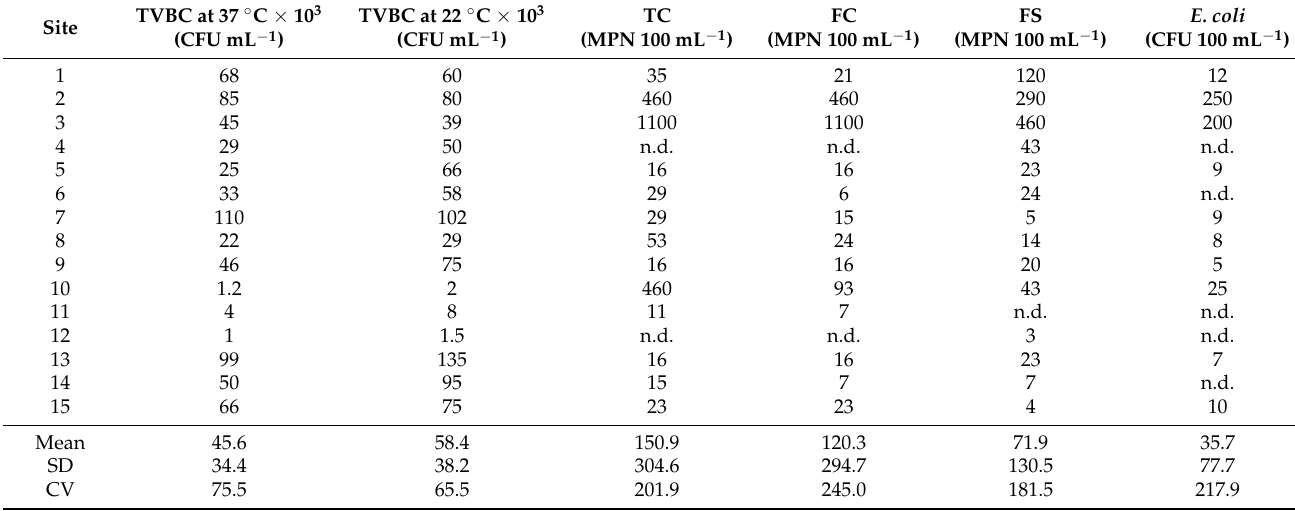
Table 3. Bacterial assessment of the main channel of Lake Nasser after flooding (the post-flood period). Site